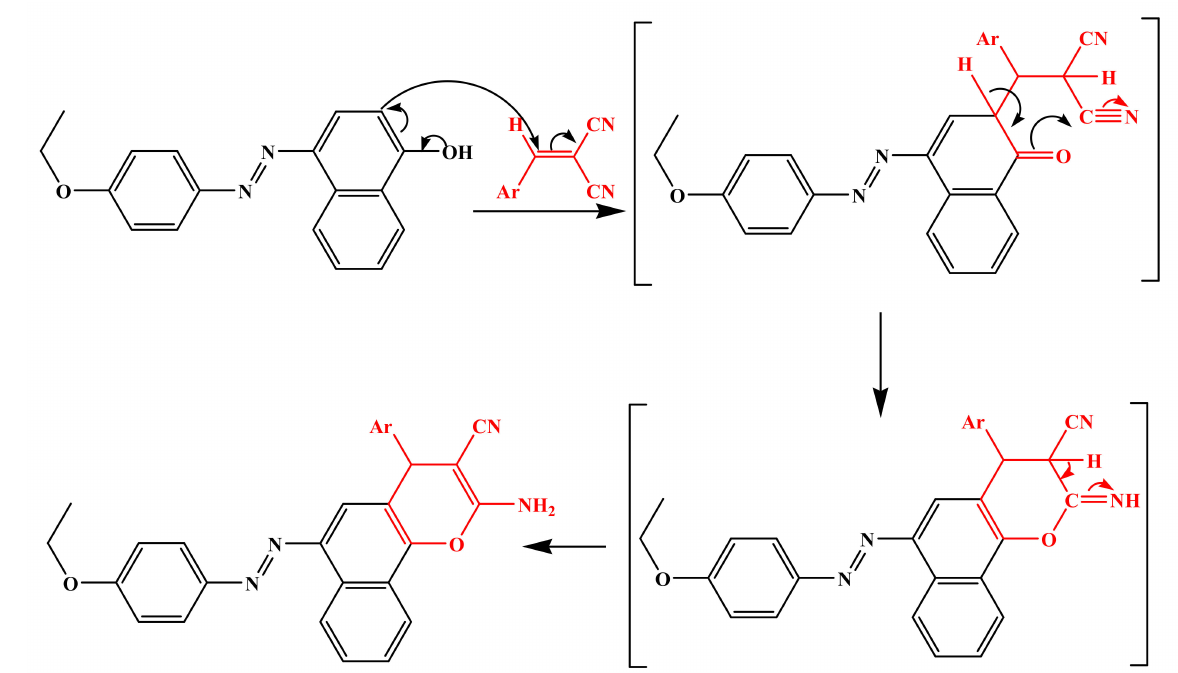
Scheme 2. Mechanistic pathway of synthesis of chromene molecules 4a-l.